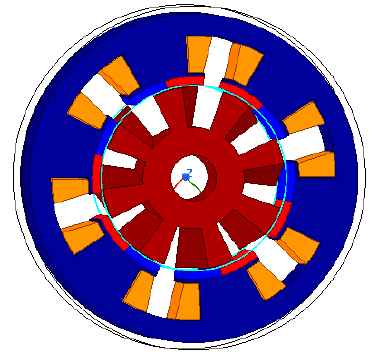
Figure 24. 3D Structural view of SKCpp.